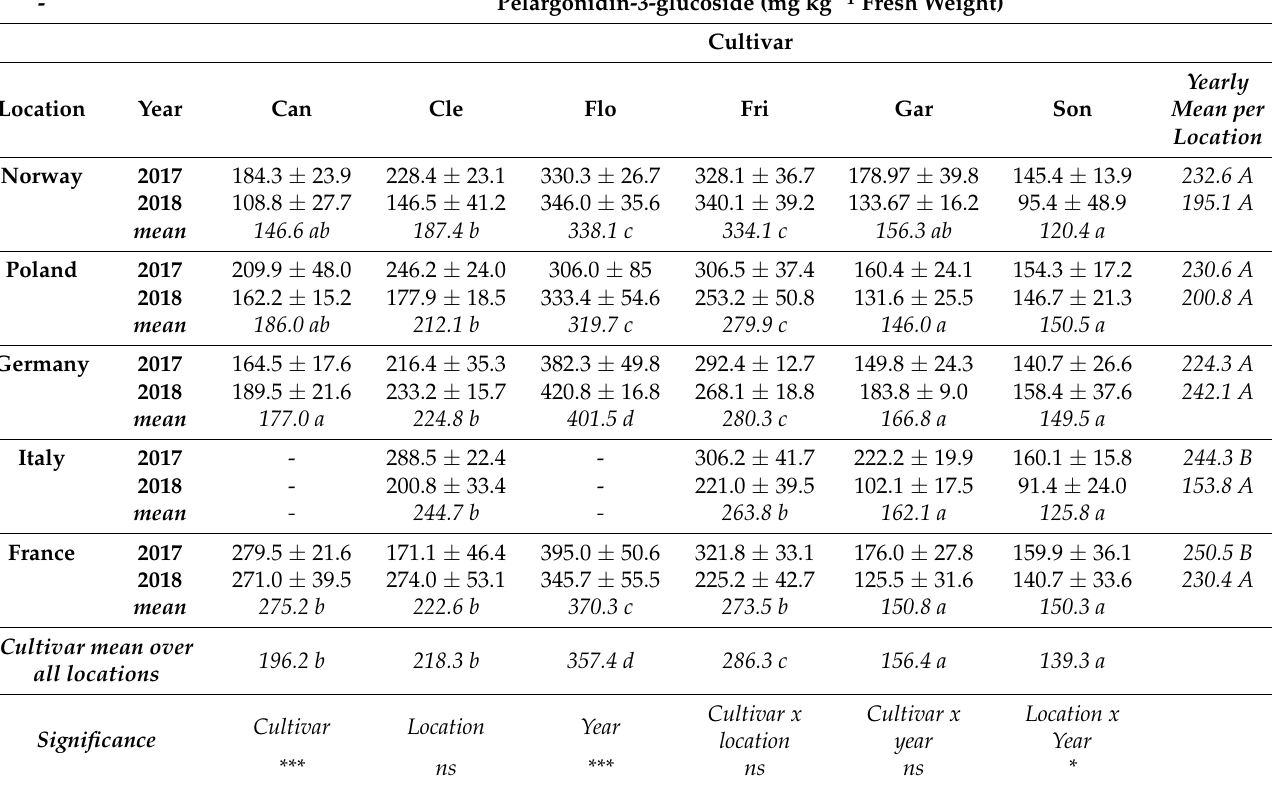
Table 4. Effect of growing location and year on pelargonidin-3-glucoside content as the mean of two picking dates in fruits of six strawberry